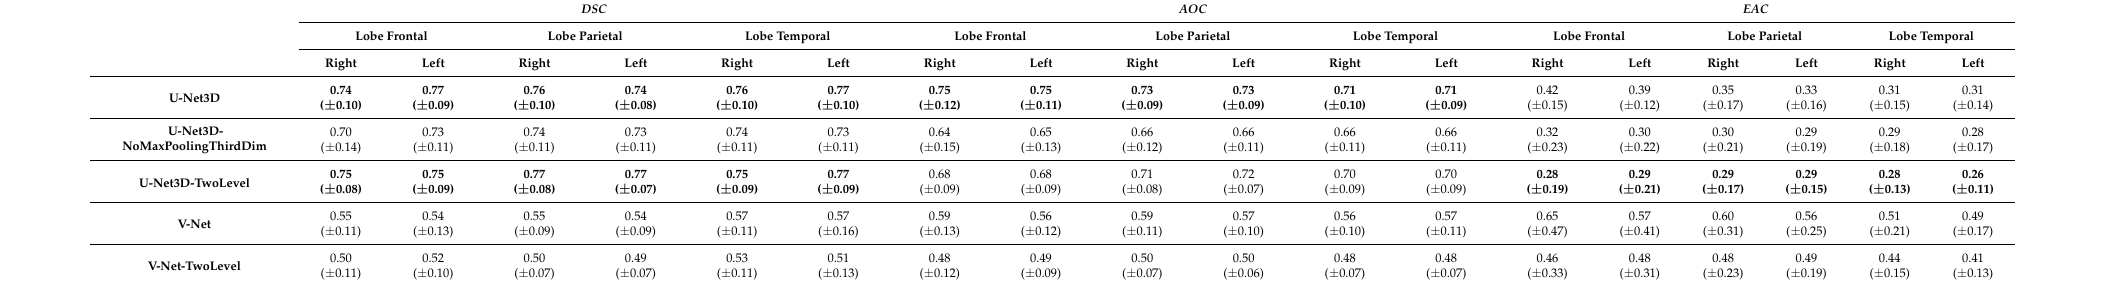
Table 3. The results of DSC , AOC , and EAC indices on test